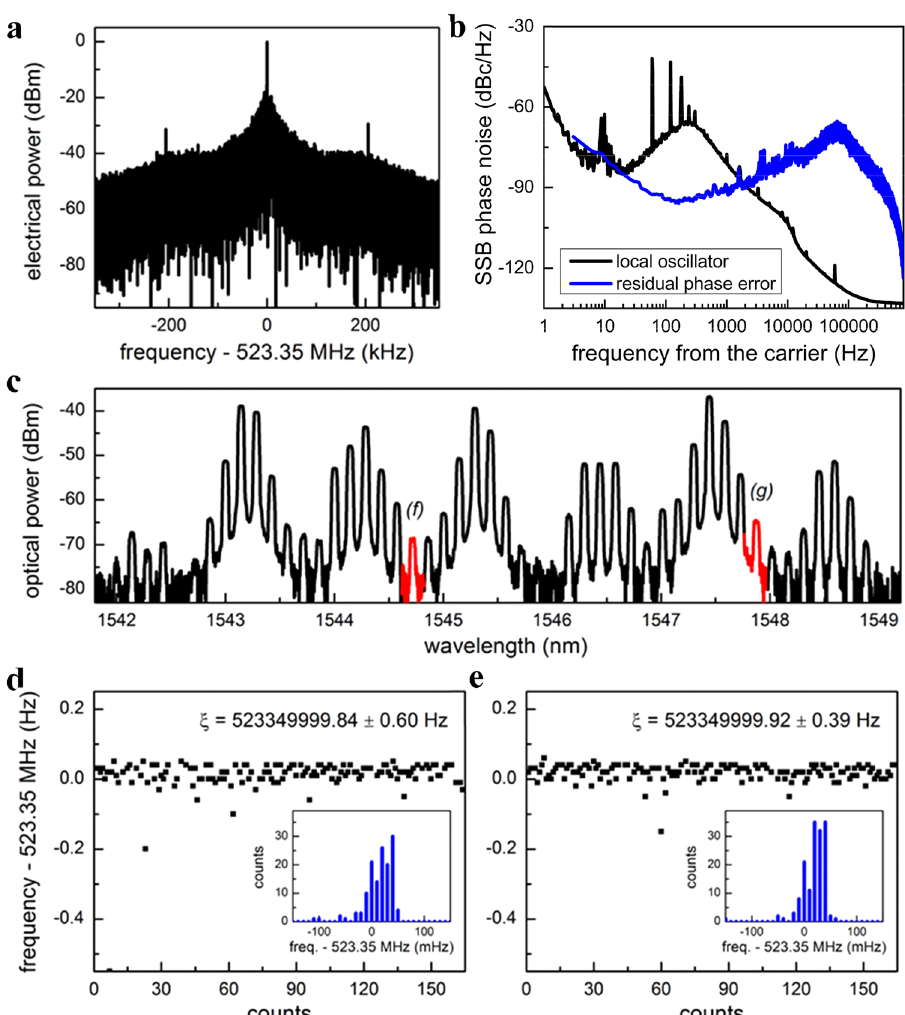
Fig. 3 Characterization of ξ feedback loop. a Electrical spectrum of the stabilized beat note of ξ with a resolution bandwidth (RBW) of 10 Hz. To minimize the crosstalk between the two phase-locked loops, here the proportional-integral corner frequency is set lower than that of the f rep loop. Furthermore, a second integrator at 500 Hz and a differentiator at 100 kHz are included to better suppress low-frequency noise and improve the loop stability, respectively. b Single-sideband (SSB) phase noise of the reference 523.35 MHz local oscillator and the residual loop error, showing excess phase noise of the stabilized ξ above 2 kHz from carrier. c To verify the uniformity of the offset frequencies, ξ are measured at two other spectral regions (marked in red; 1544.72 nm and 1547.86nm) beside the 1553.5 nm region where the beat note is stabilized to 523350000 Hz in the phase-locked loop. The selected spectral segments are representative as each ξ is generated from the overlap of different groups of secondary comb lines. ( d ) and ( e ) Counter results and the corresponding histogram analysis (insets). The mean value at 1544.72 nm is 523349999.84 Hz, the standard deviation over 160 measurements is 600 mHz, and the interquartile range is 50 mHz. The mean value at 1547.86nm is 523349999.92 Hz, the standard deviation over 160 measurements is 390 mHz, and the interquartile range is 40